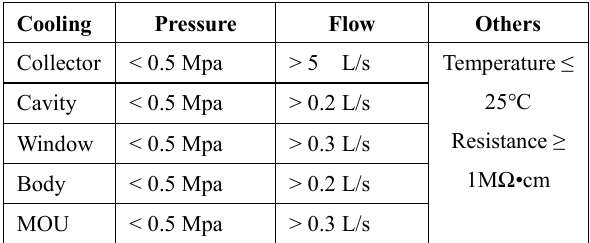
Table 3 . Parameters of water cooling.